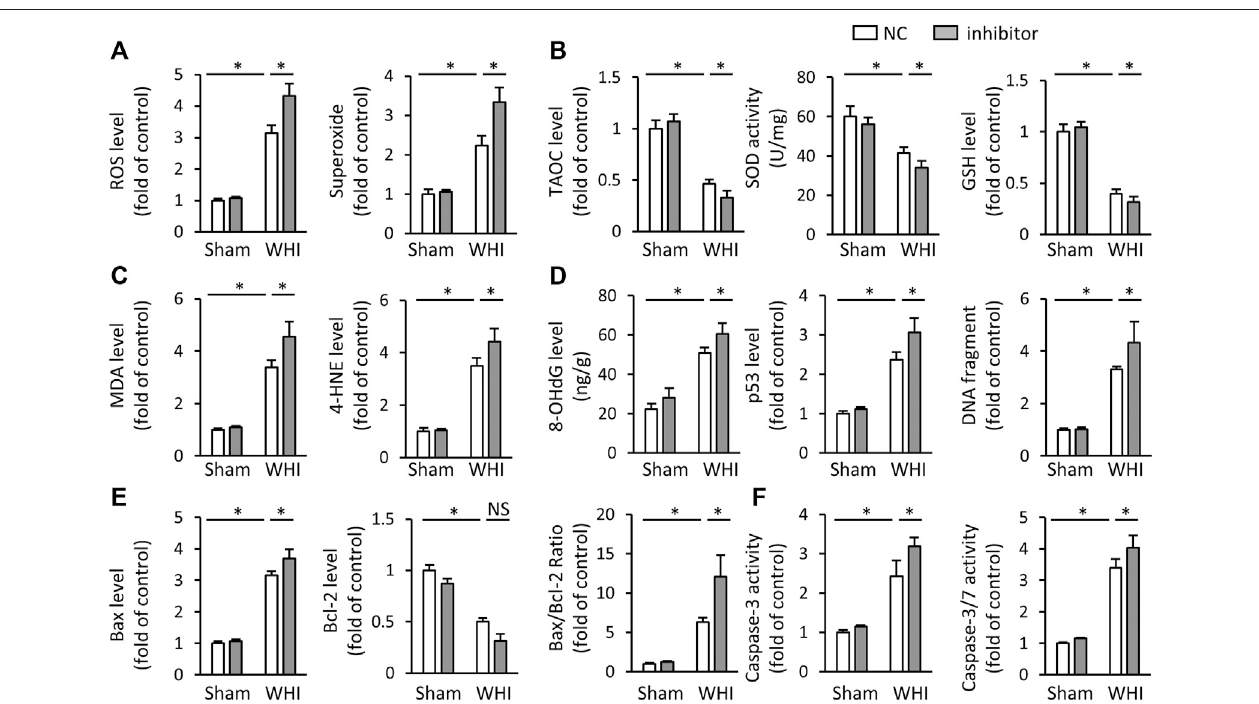
FIGURE4 | miR-223-3p inhibitor aggravates oxidative stress and programmed cell death in RIHD mice. (A) ROS and superoxidelevel inthe hearts withor without miR-223-3p inhibitor ( n (cid:2) 6). (B) The relative levels of TAOC and total SOD activity and GSH ( n (cid:2) 6). (C) Oxidative products levels in mice with or without miR-223-3p inhibitor( n (cid:2) 6). (D) Quantitativeresultsof8-OHdG,p53,andDNAfragmentineachgroup( n (cid:2) 6). (E) RelativemRNAlevelsof Bax and Bcl-2 andtheratioofBax/Bcl-2in the hearts ( n (cid:2) 6). (F) Quantitative results of caspase-3 and caspase-3/7 activity in each group ( n (cid:2) 6). All data are presented as means ± SD. * p < 0.05 vs. the matched